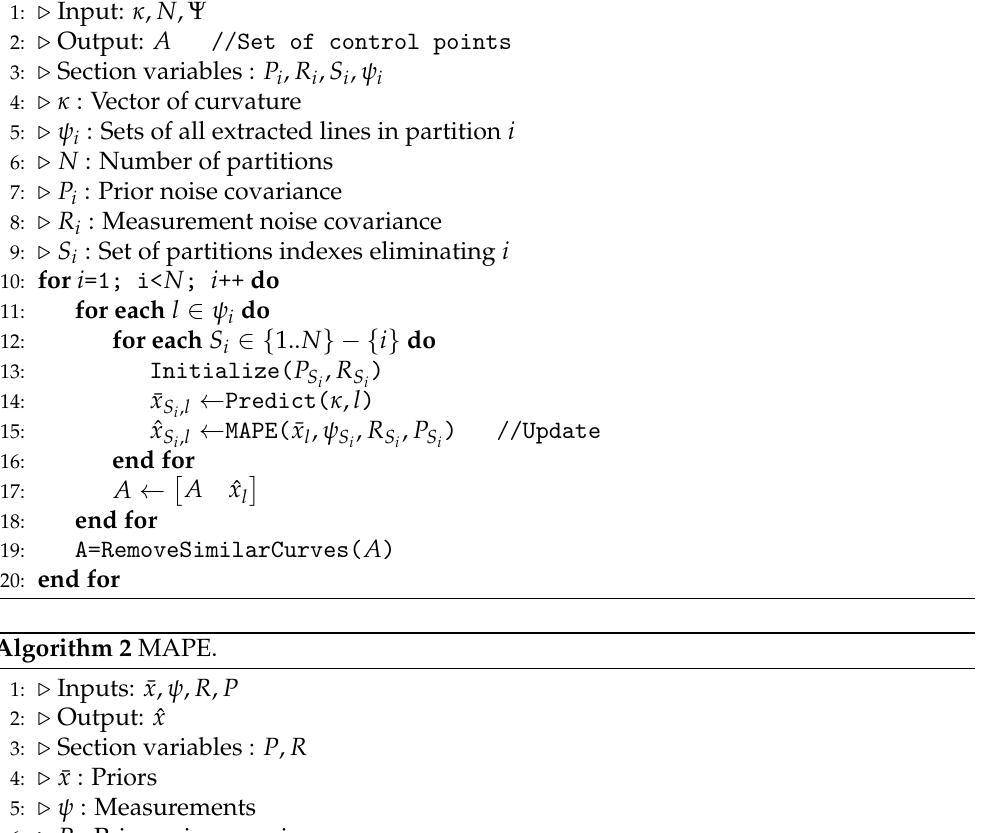
Algorithm 1 Control Points Estimator